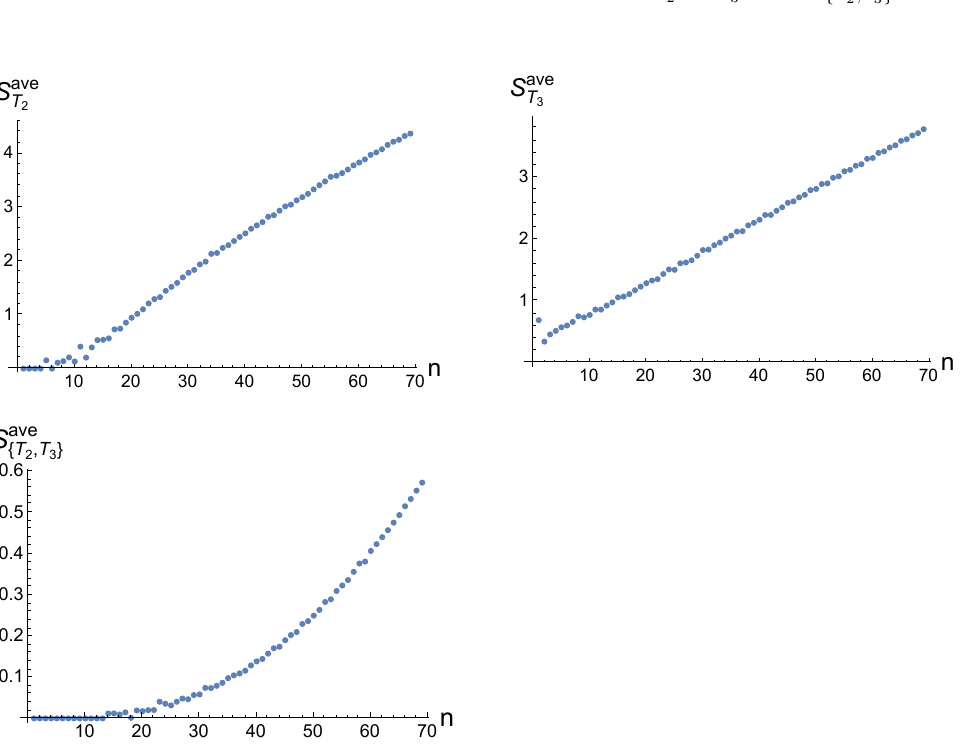
, S ave and S ave : T 2 T 3 T 2 ;T 3 f g